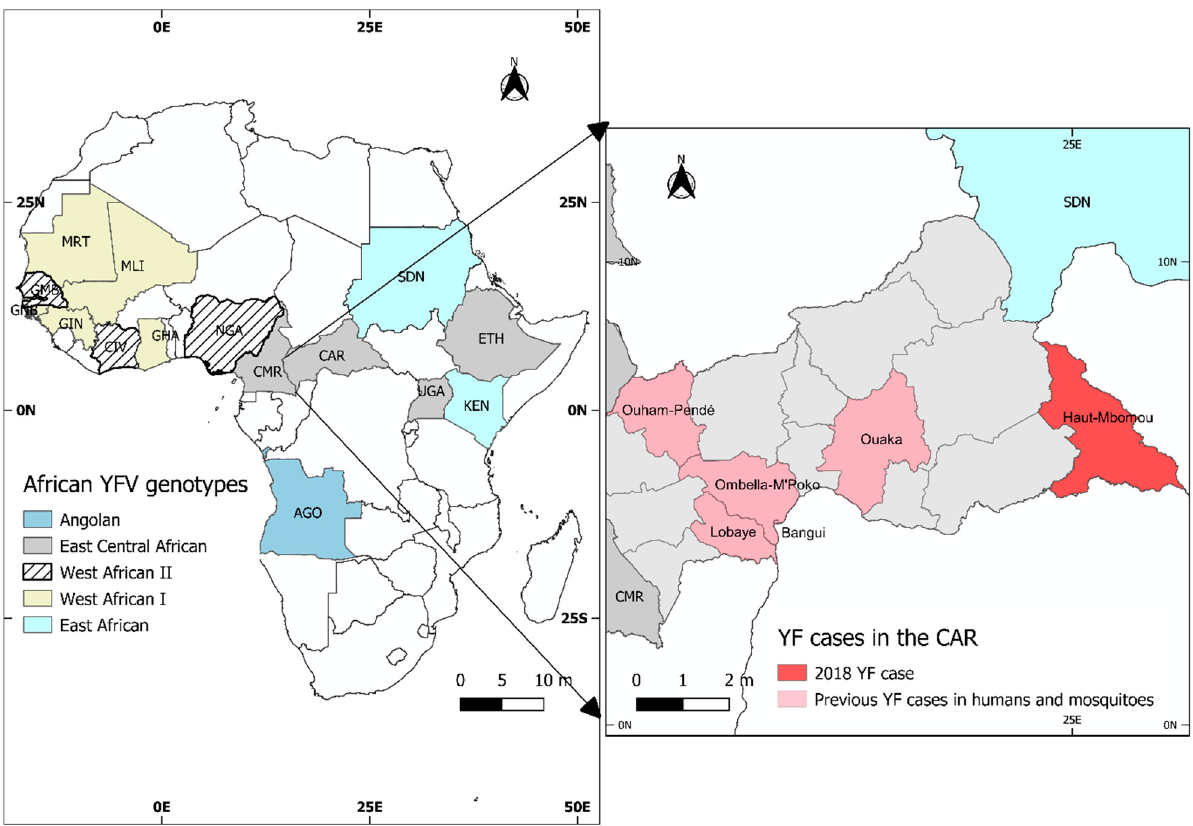
Figure 1. Origin of the African yellow-fever virus (YFV) sequences used in this study. The left panel shows the geographic distribution of YFV genotypes in Africa. The right panel shows the distribution of YFV cases in the CAR, including the region of origin of the case described in this study.